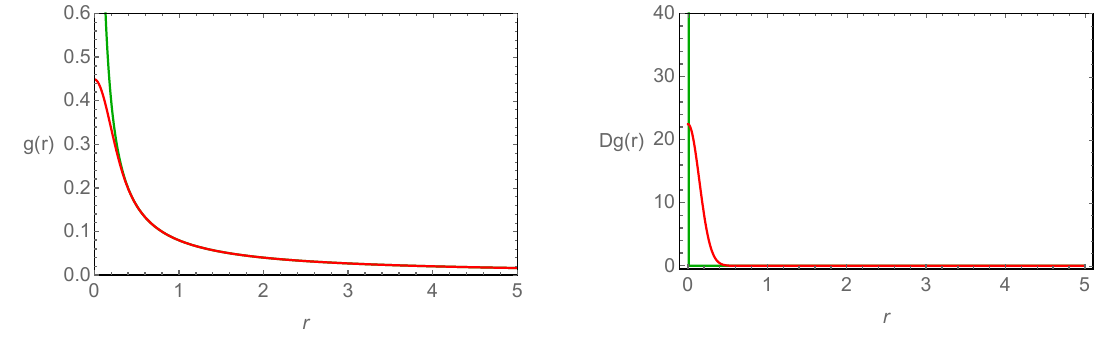
Figure 8 . Left: Coarse-grained two-point function g ‘ ( r ) for ‘ = 0 : 1 (red) compared to original g 0 = D (cid:0) 1 (green). Right: (cid:14) ‘ = D g ‘ (red) vs (cid:14) = (cid:14) 0 = D g 0